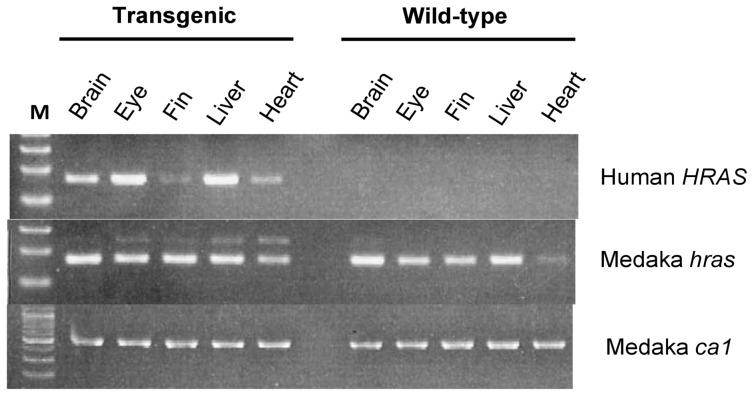
Double-transgenic medaka expresses human HRASG12V.Total RNA isolated from the indicated tissues both of Tg(tyr:HRASG12V)/Tg(hsp:cre) double-transgenic medaka at 8 mpf (with heat treatment at 4 wpf) and of wild-type medaka was subjected to RT-PCR analysis of human HRAS and medaka hras. Transcripts of the medaka cytoplasmic actin gene (ca1) were examined as an internal control of RNA quality. Lane M, DNA size markers.